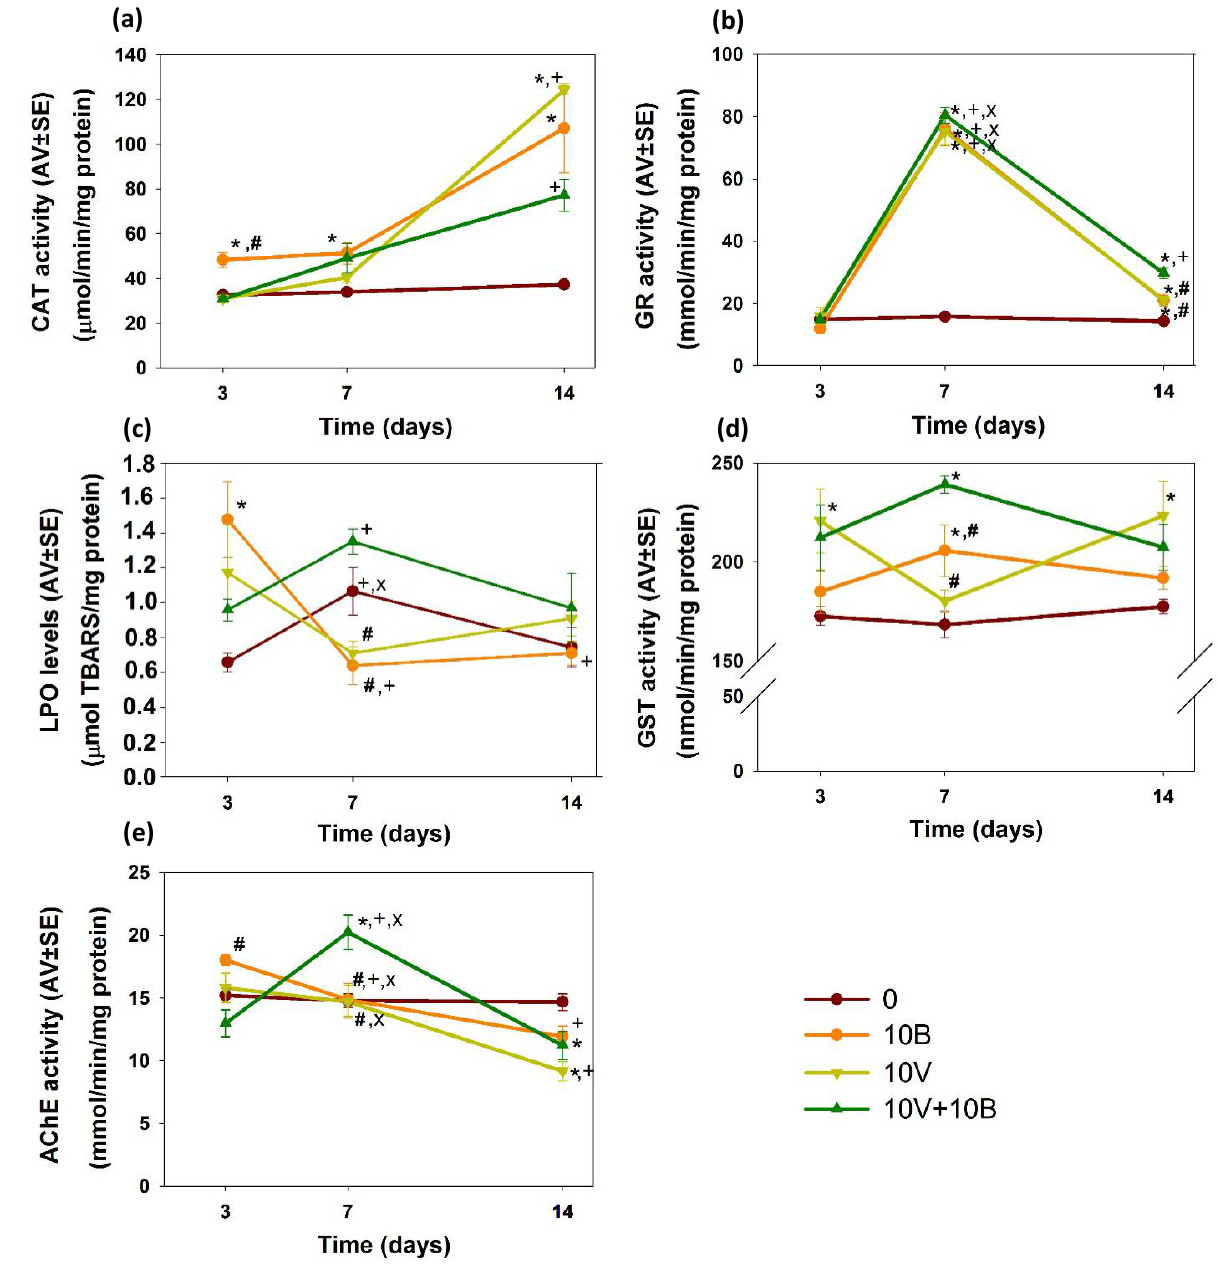
Figure 2. Effects on ( a ) catalase (CAT), ( b ) glutathione reductase (GR), ( c ) lipid peroxidation (LPO) levels, ( d ) glutathione-s-transferase (GST) and ( e ) acetylcholinesterase (AChE) activities of Enchytraeus crypticus exposed during 3, 7 and 14 days to: 0—control and solvent control; 10B—10 mg BNPs/kg soil; 10V—10 mg VNPs/kg soil; 10V + 10B—10 mg VNPs + 10 mg BNPs/kg soil, in LUFA 2.2 soil. Results are expressed as average values (AV) ± standard errors (SE) ( n = 5). Significant differences ( p < 0.05) relative to: (*) control group; (#) 10V + 10B; (+) day 3; (x) day 14.